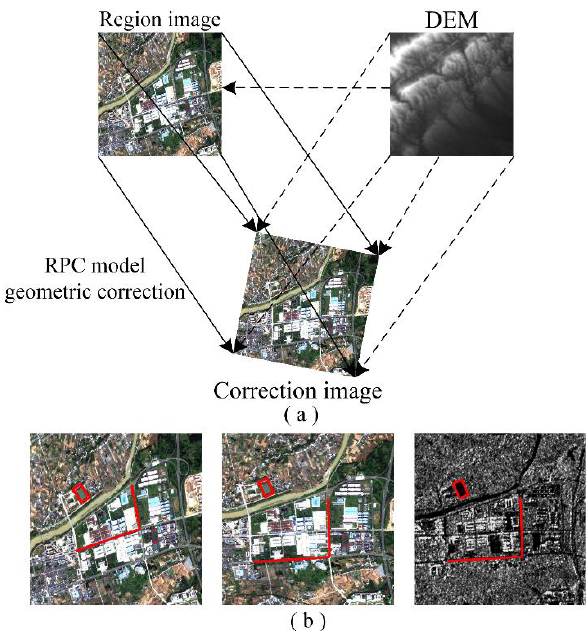
Figure 3. (a) Process of local geometric correction. (b) Comparison of the optical image before and after correction. Optical image before correction (left), Optical image after correction (middle), SAR image